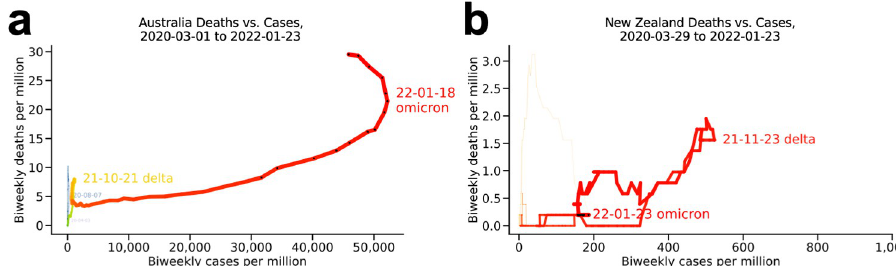
Fig 6. Australia and New Zealand. (a) Australia and (b) New